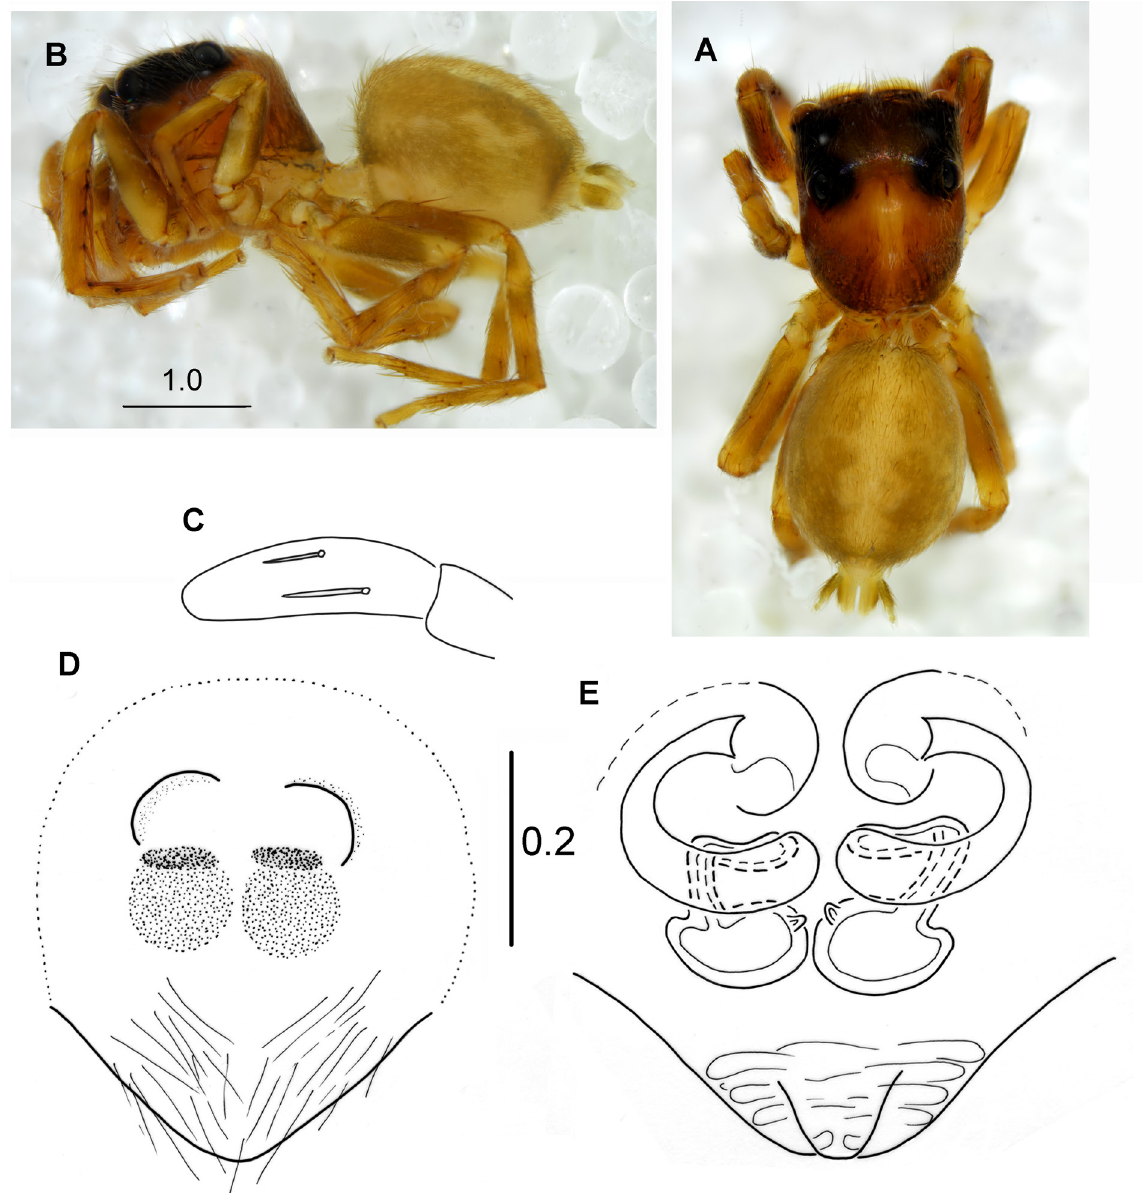
Fig. 33. Malizna zabkai sp. nov., holotype, ♀ (MNHN). A . Habitus, dorsal view. B . Habitus, lateral view. C . Pedipalp, retrolateral view. D . Epigyne. E . Internal structure of